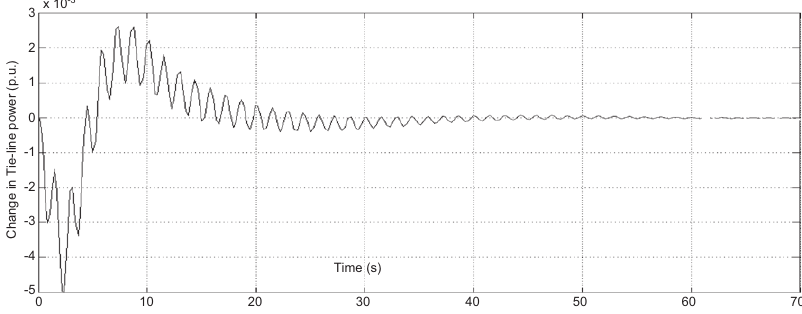
Figure 8. Change in Tie-Line Power (Hydro-Thermal Plant): With PI Controller.